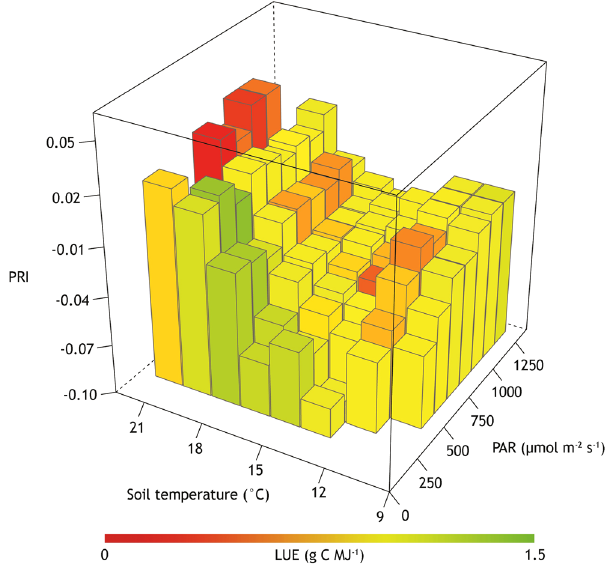
Figure 6. PRI for different PAR and soil temperatures at 5 cm depth. Low PAR values (i.e., diffuse light) generally correspond to lower stress level (i.e., high LUE; green), whereas high temperature to higher stress (i.e., low LUE;